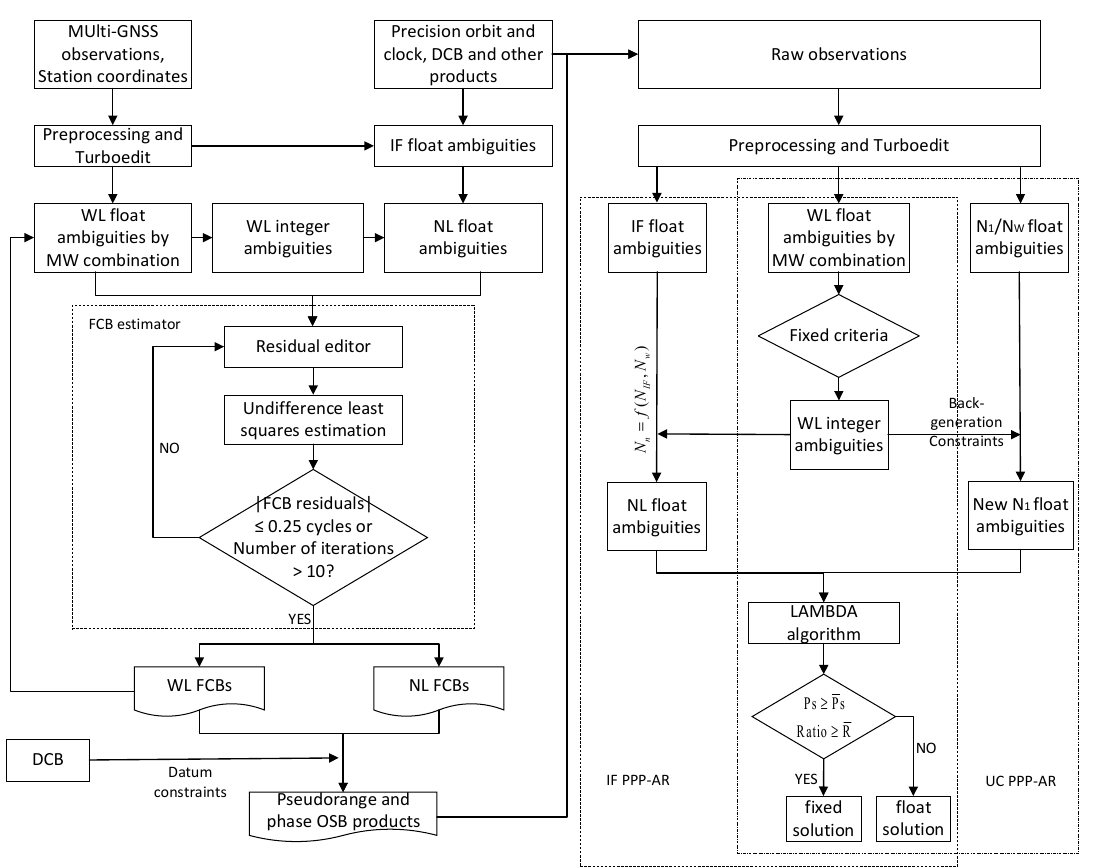
Figure 1. The flowchart of the OSB estimation and PPP-AR.